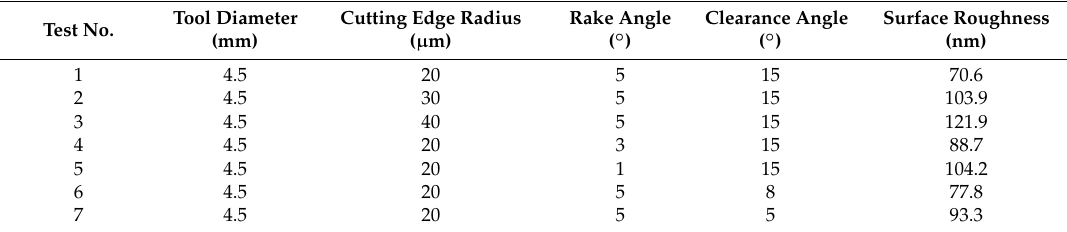
Table 3. Experimental matrix of micro-machining of titanium alloy and responses: measured surface roughness.